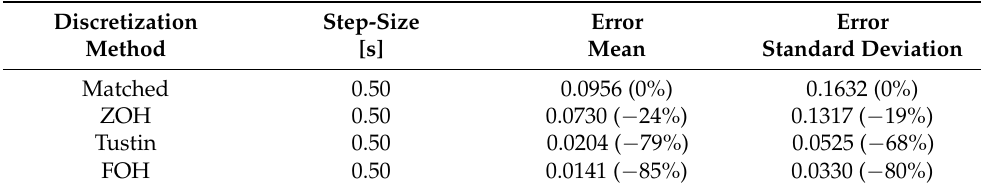
Table 3. Comparison of different discretization methods in discrete D.A.I.